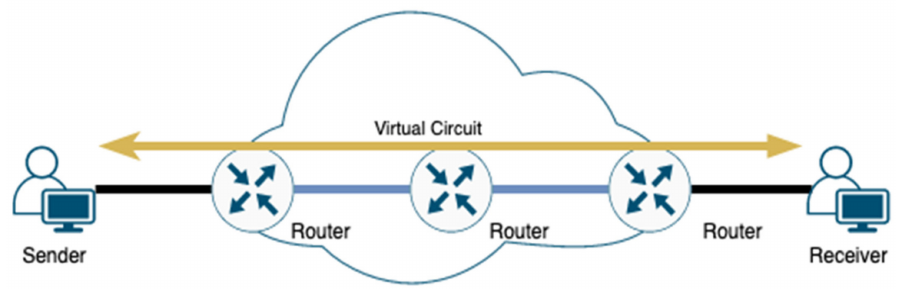
Figure 2. Virtual channel established by RSVP.